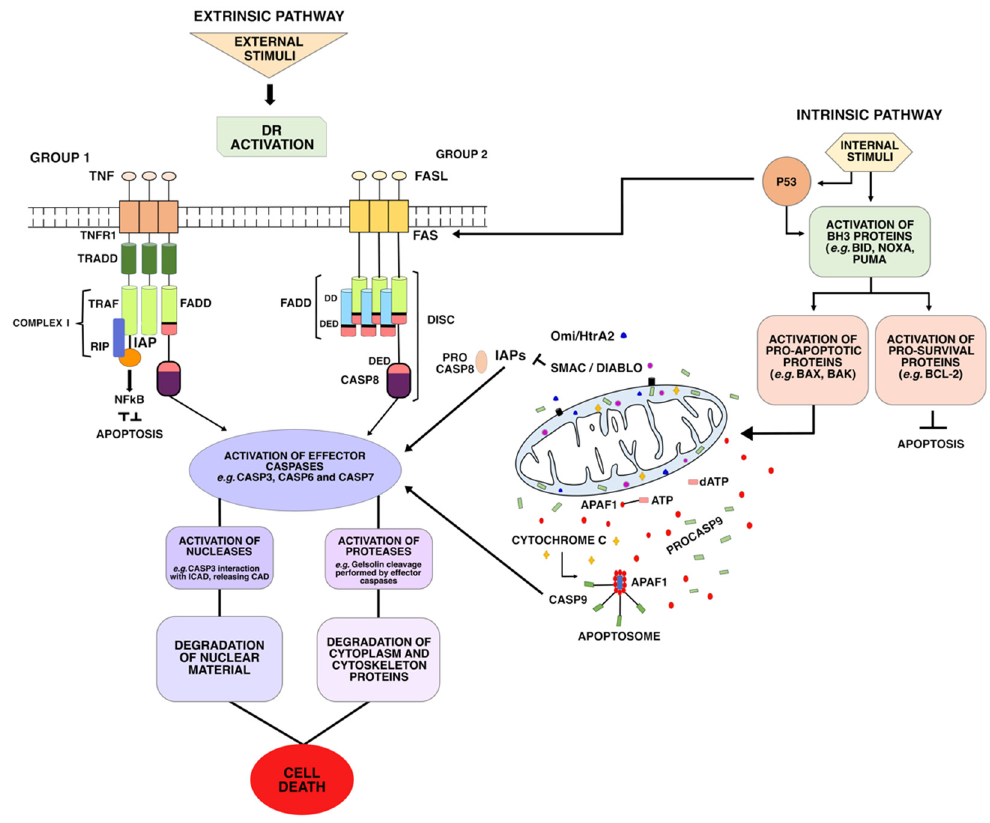
Figure 1. General scheme of the process of apoptotic cell death. This phenomenon may occur via the extrinsic or intrinsic pathway, converging in the executing phase.